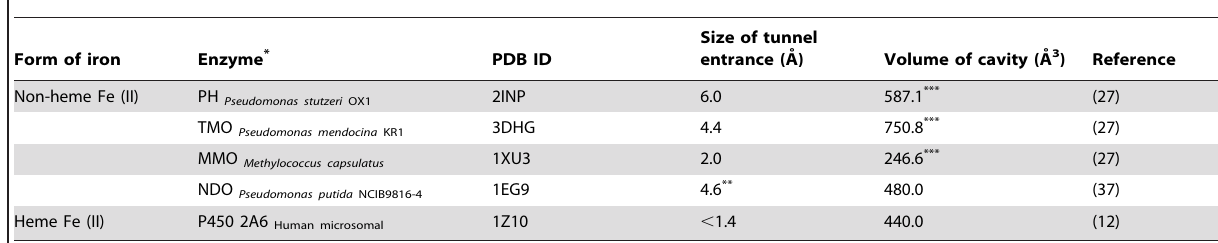
Table 2. Comparisons of active sites in various